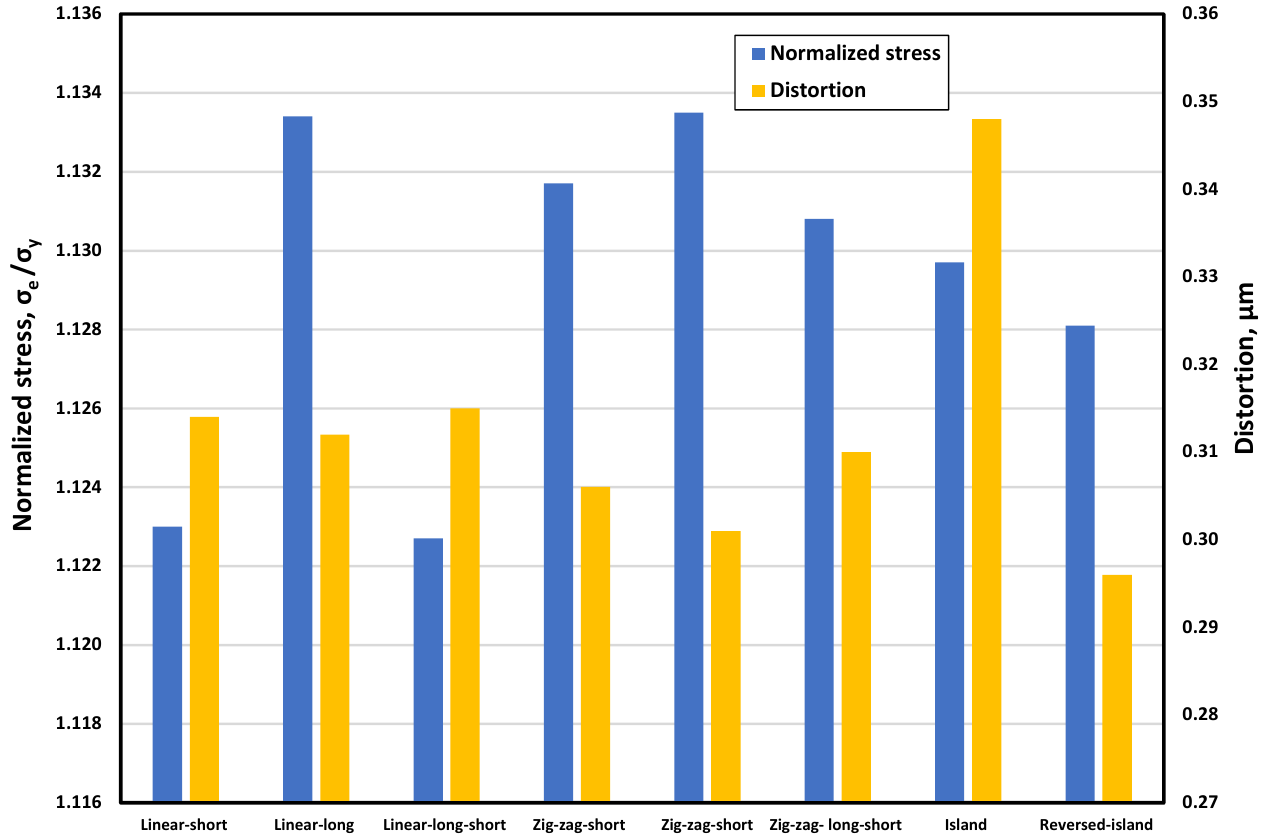
Figure 15. Residual stress and distortion for different build orientations.